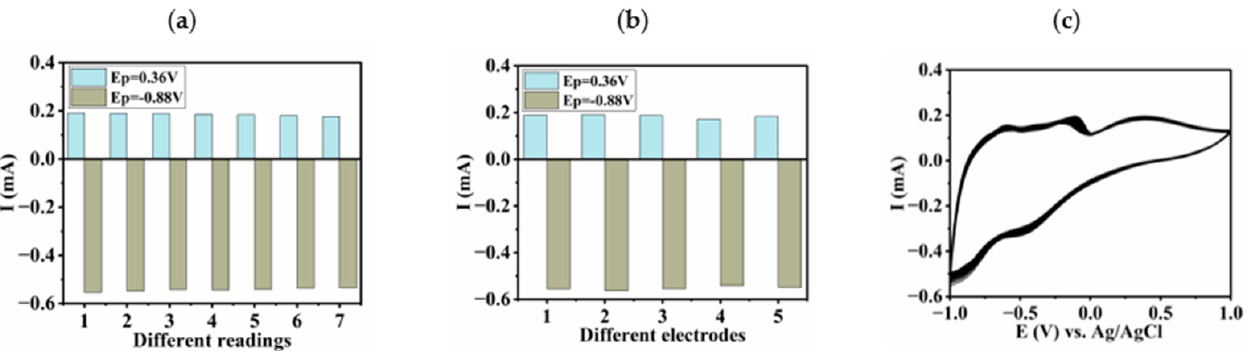
Figure 11. The current value of the ITO/(Cu 4 P 4 W 30 /PDDA-GO) 7 electrode continuously recorded 7 times in 10 µ m 2,4-DNPH solution at E p = − 0.88 V and 0.36 V ( a ); the recorded current values of five ITO/(Cu 4 P 4 W 30 /PDDA-GO) 7 electrodes prepared in different days in 10 µ m 2,4-DNPH solution at E p = − 0.88 V and 0.36 V ( b ); CVs of the ITO/(Cu 4 P 4 W 30 /PDDA-GO) 7 electrode in 10 µM 2,4-DNPH scanned continuously for 100 times at pH 7.0 at a scan rate of 50 mV·s − 1 ( c ).